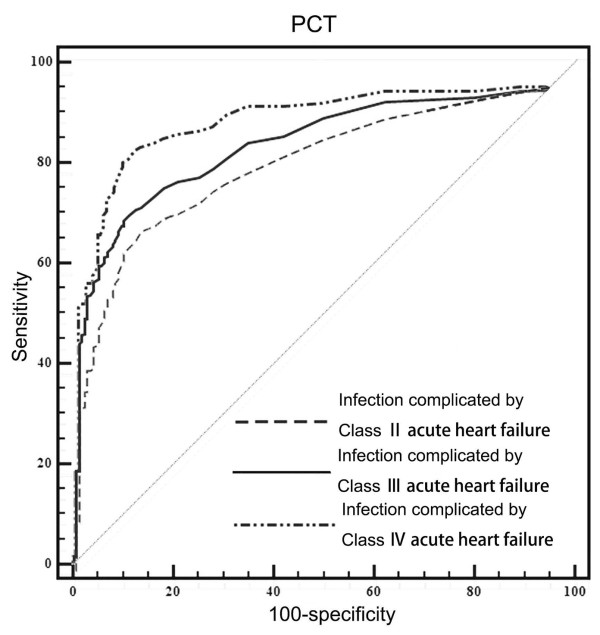
Receiver operating characteristic curve for procalcitonin-based diagnosis of infections complicated by different classes of heart failure. As depicted, procalcitonin (PCT) had high areas under the receiver operating characteristic curve in each heart failure group. However, the best cutoff values for each group were different.